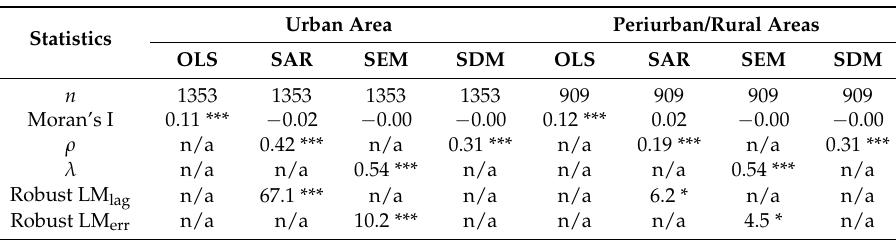
Table 2. Model diagnostics for Ordinary Least Squares (OLS), Spatial AutoRegressive model (SAR), Spatial Error Model (SEM) and Spatial Durbin Model (SDM) in the two